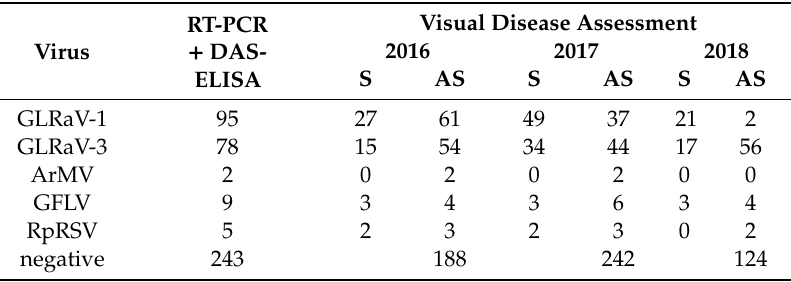
Table A2. Number of field plants tested positive or negative by RT-PCR as well as double antibody sandwich (DAS)-ELISA and visually assessed as symptomatic (S) or asymptomatic (AS). Visual Disease RT-PCR + DAS- Virus ELISA